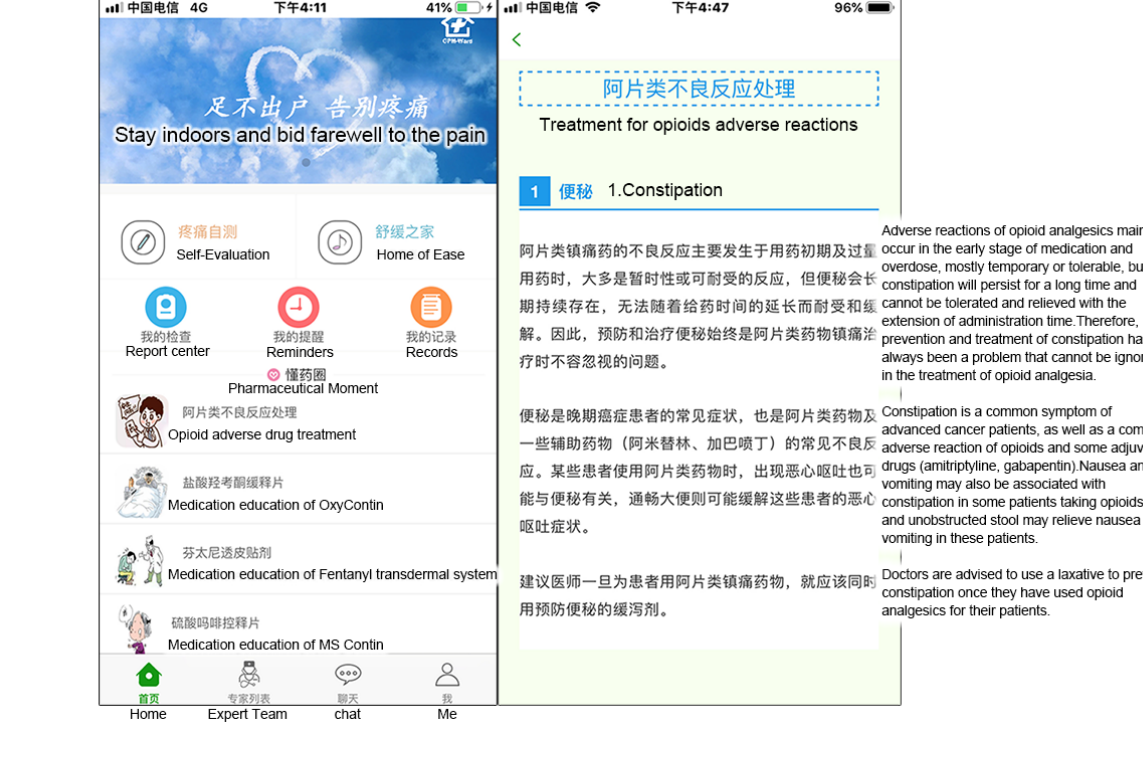
Figure 8. Screenshot of the My Center